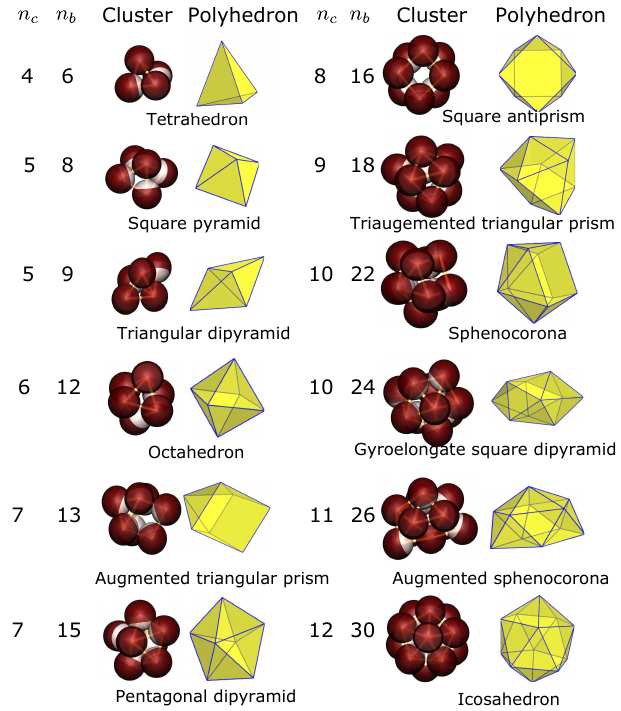
Figure 3. Typical cluster structures obtained in simulations (middle columns) at surface coverage χ = 0.25. The white colloid patch is attractive and the red one is repulsive. The wire frame connecting the colloid centers illustrates the bond skeleton. Shown in the left columns are the number of constituent colloids n c and the number of bonds n b of the corresponding clusters. Right columns illustrate the polyhedra formed by drawing lines from the center of the colloidal sphere to its neighbors. Below are the names of the polyhedra from